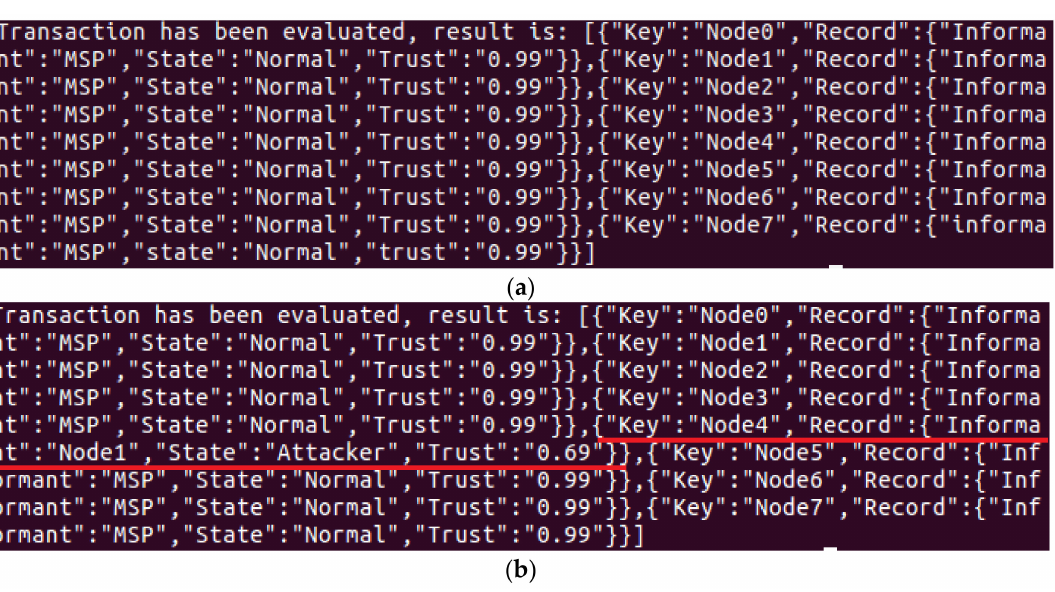
Figure 9. The sample result of querying. ( a ) the initialized ledger; ( b ) the updated